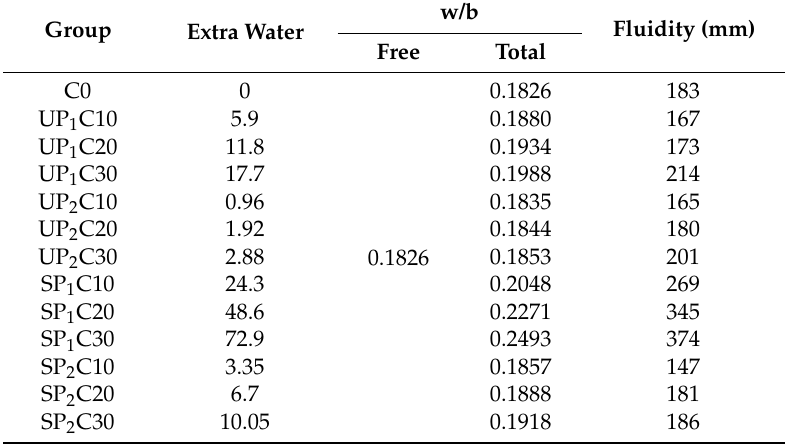
Table 3. Fluidity of the designed UHPC with different amounts of extra water introduced by wet